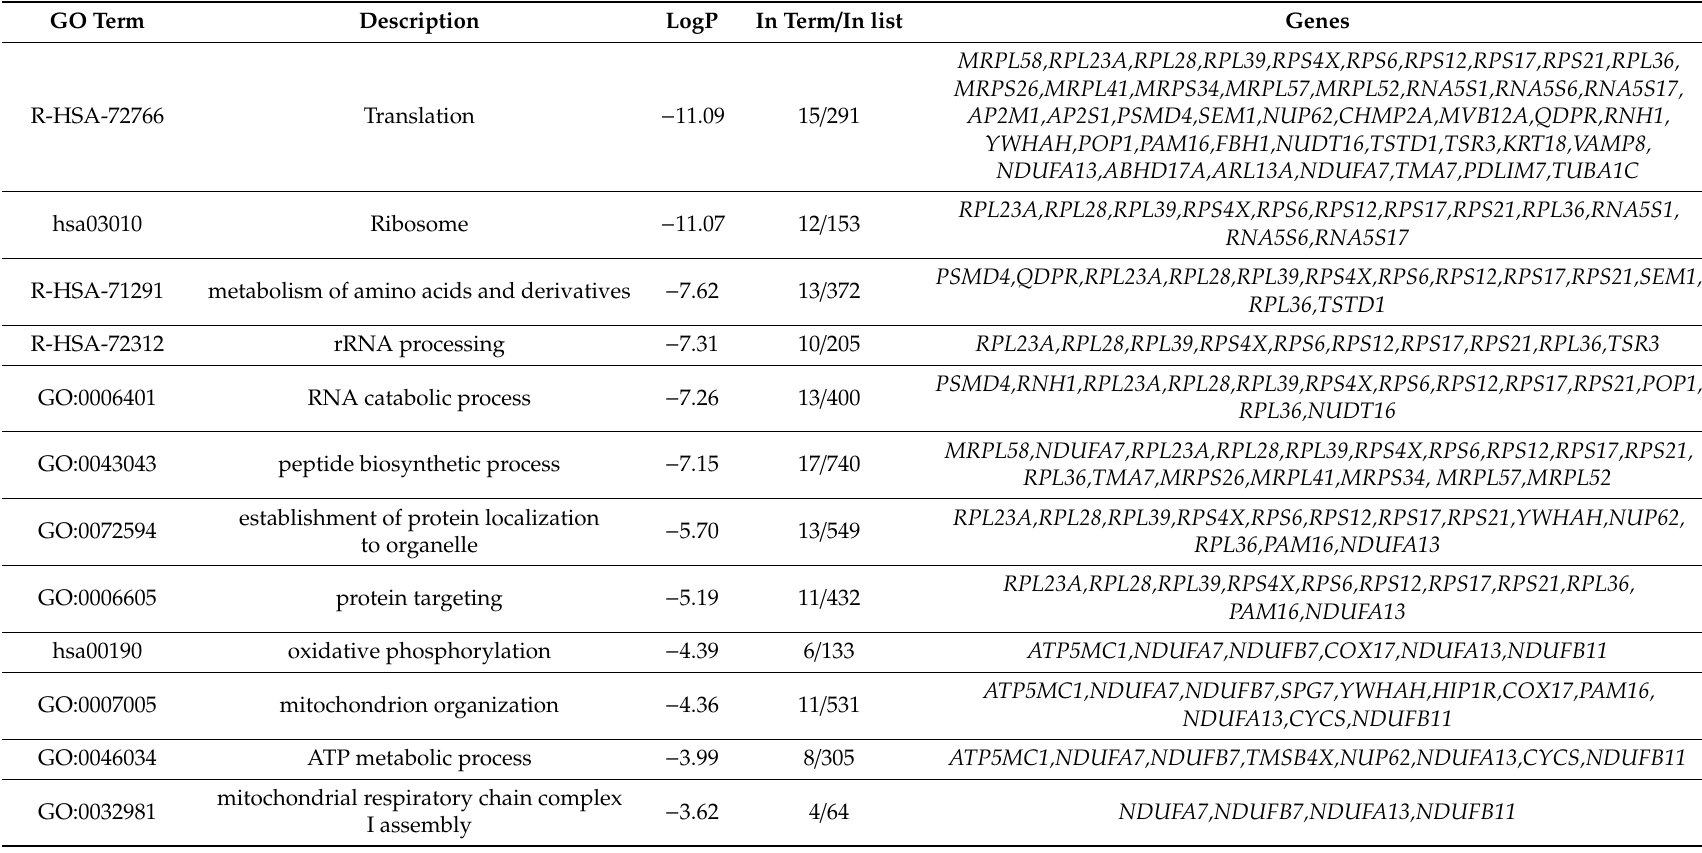
Table 2. Metascape functional annotation clusters for upregulated genes in embryos treated with FoEVs compared to